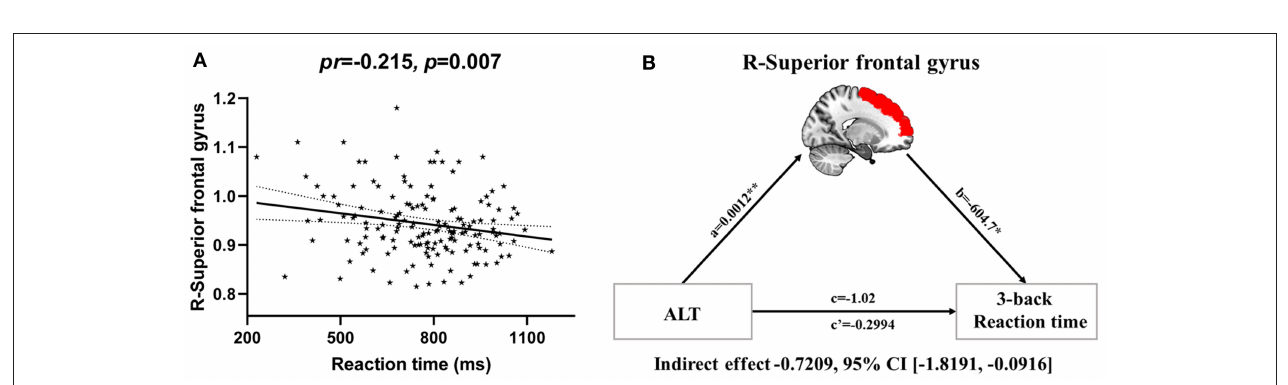
FIGURE 6 | CBF mediating the relationship between serum ALT and working memory. (A) Scatter plot of the correlation between CBF in the right superior frontal gyrus and 3-back mean reaction time. (B) The mediation analysis between serum ALT level (X) and 3-back reaction time (Y), with CBF in the right superior frontal gyrus as the mediator (M). Path coefficients with p values (* p < 0.05 and ** p < 0.01, respectively). Abbreviations: CBF, cerebral blood flow; ALT, alanine transaminase.